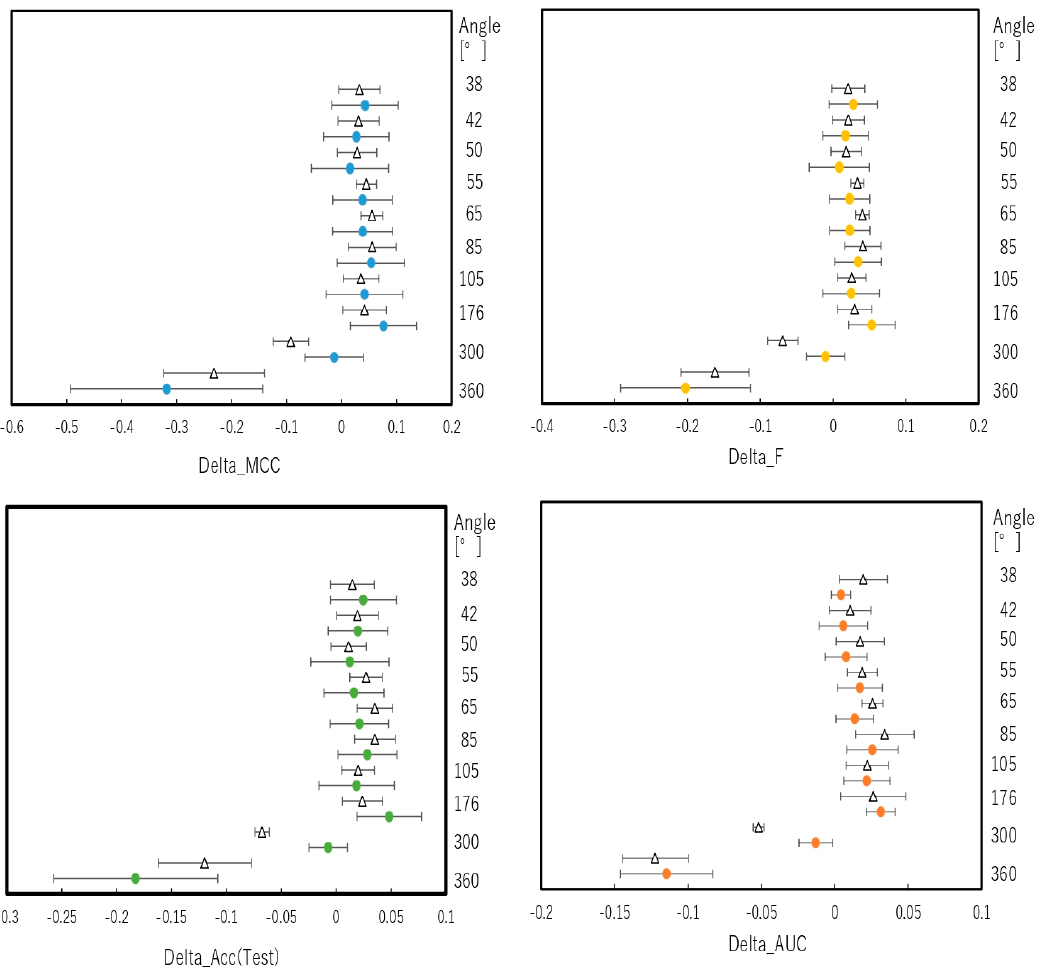
Figure 1. Difference in the mean levels of performance of DeepSnap at different angles. Differences in the mean values of the performance indicators between one angle and the other nine angles, denoted as Delta_MCC, Delta_Acc (Test), Delta_F, and Delta_AUC, were calculated based on the results shown in Figure 1, with a 95% confident interval (CI) as error bars. The filled dots and unfilled triangles indicate the dataset ratios Tra/Val/Test = 1:1:1 and 2:2:1, respectively.